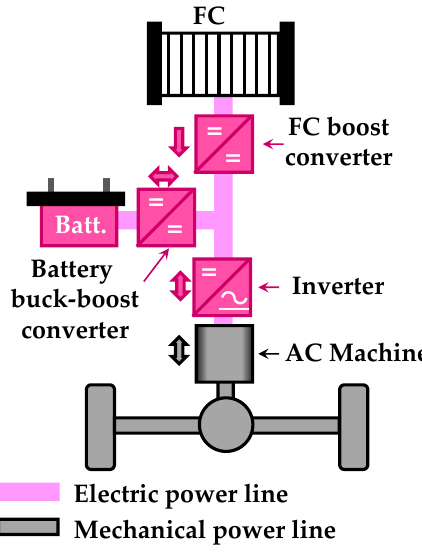
Figure 20. FCV hybrid drive train.